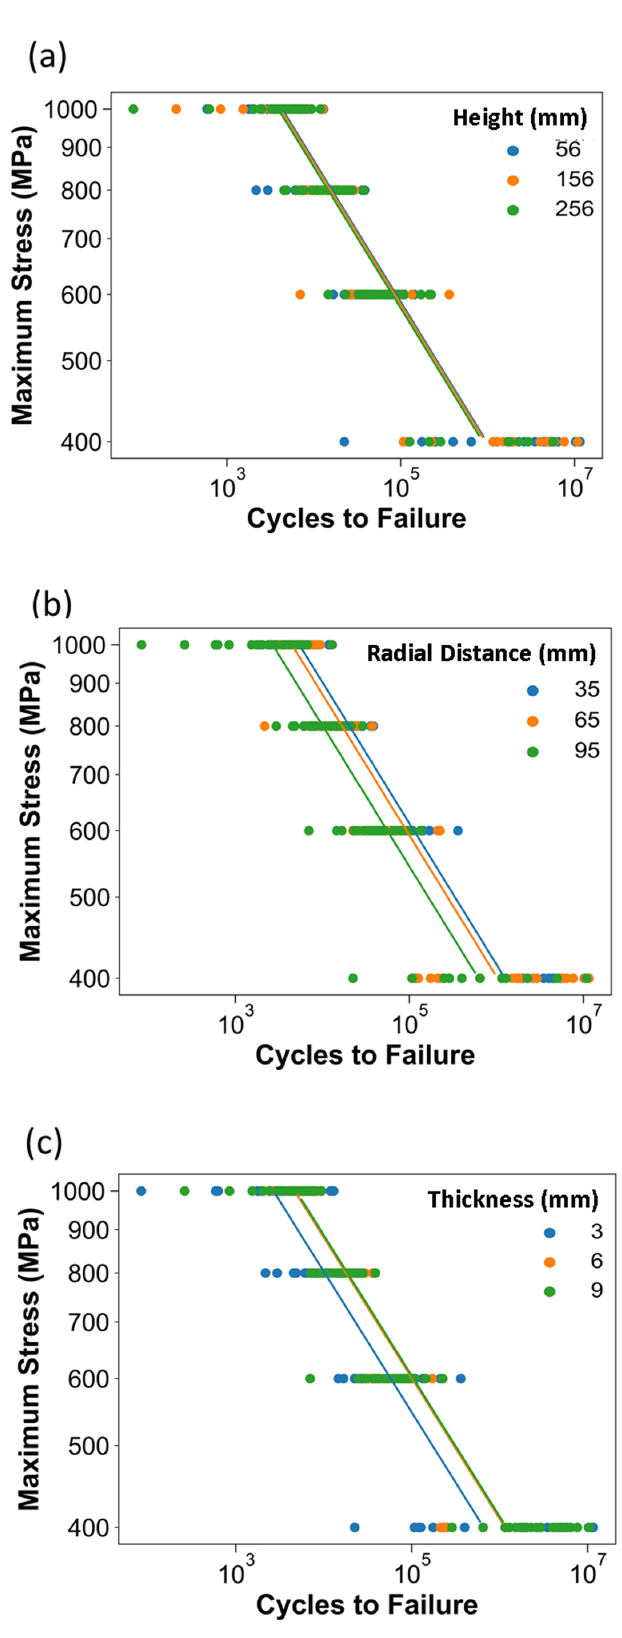
Figure 5. Stress–life diagrams for data (machined condition) from the DOE with Basquin model fits. Shown are the influence of ( a ) height, ( b ) radial distance, and ( c ) thickness factor